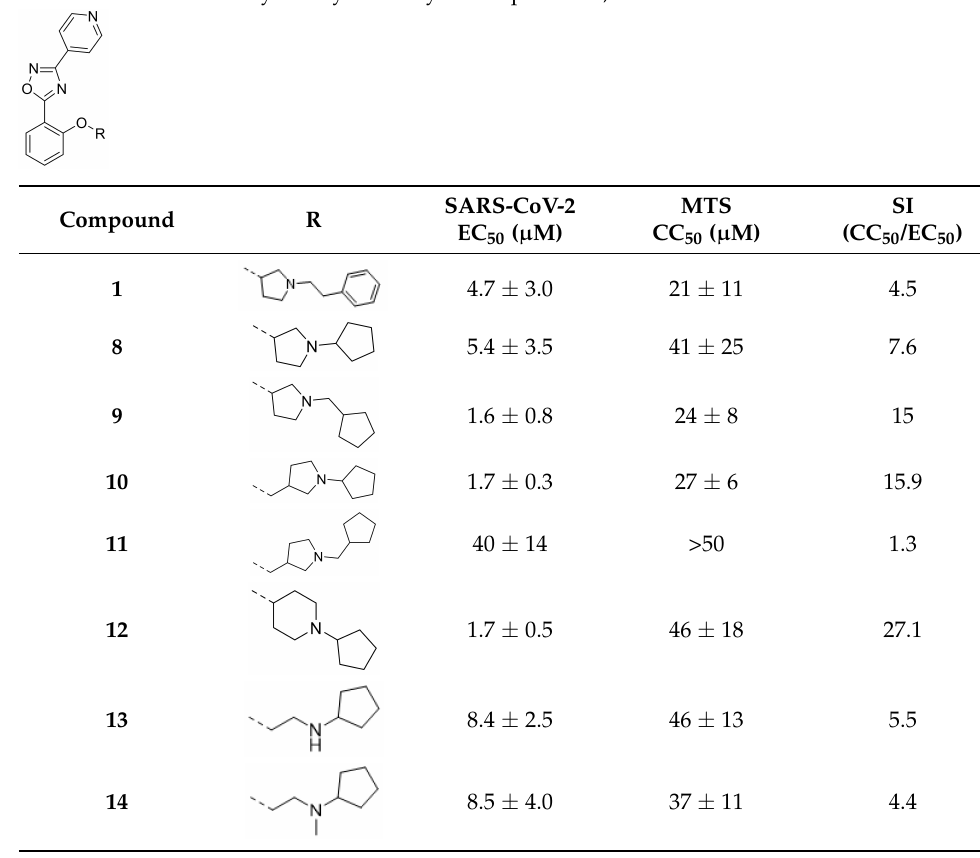
Table 2. Antiviral activity and cytotoxicity of compounds 1 , 8 – 14 .